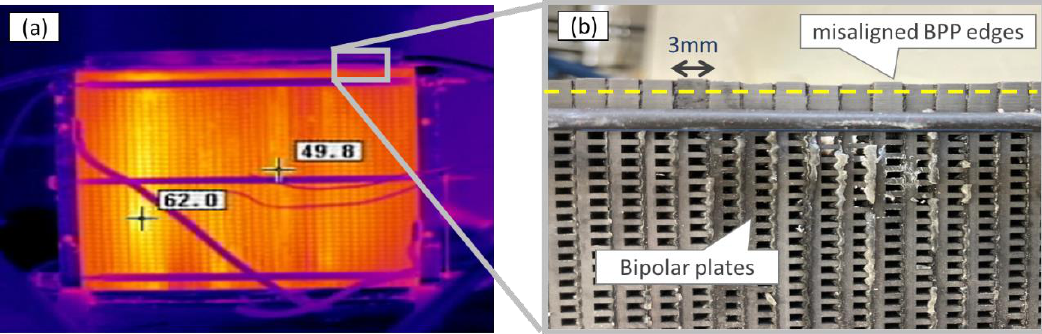
Figure 10. ( a ) Temperature distribution of the edge-cooled FC (in a case without WRS); ( b ) magni- fied side view of the utilized PEMFC with graphite bipolar plates showing BPP edges misalignment. side view of the utilized PEMFC with graphite bipolar plates showing BPP edges